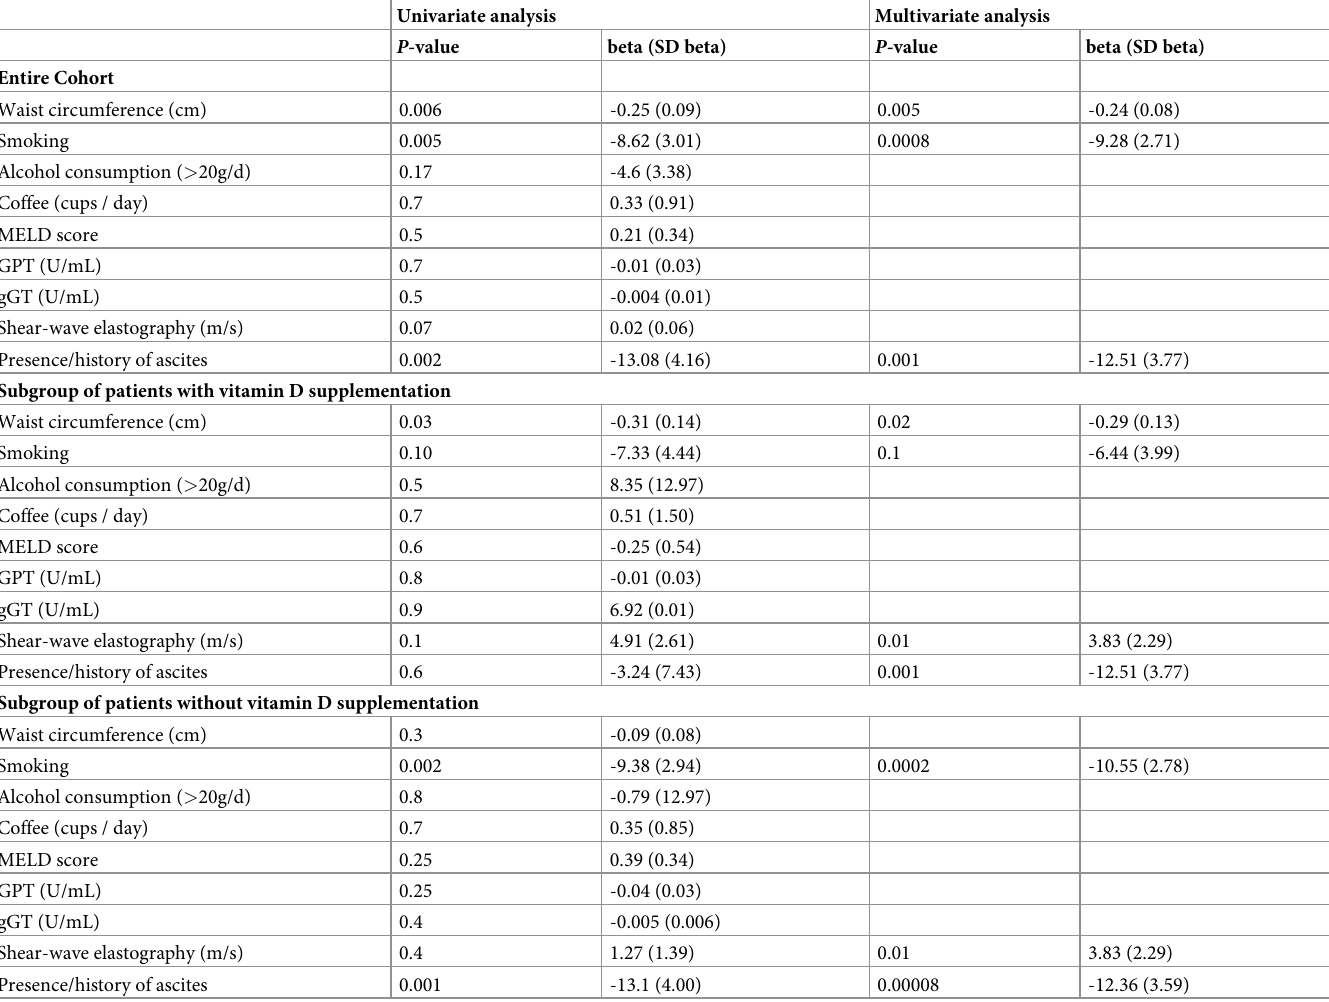
Table 3. Linear regression analyses of 25(OH)D 3 serum levels in patients with advanced liver